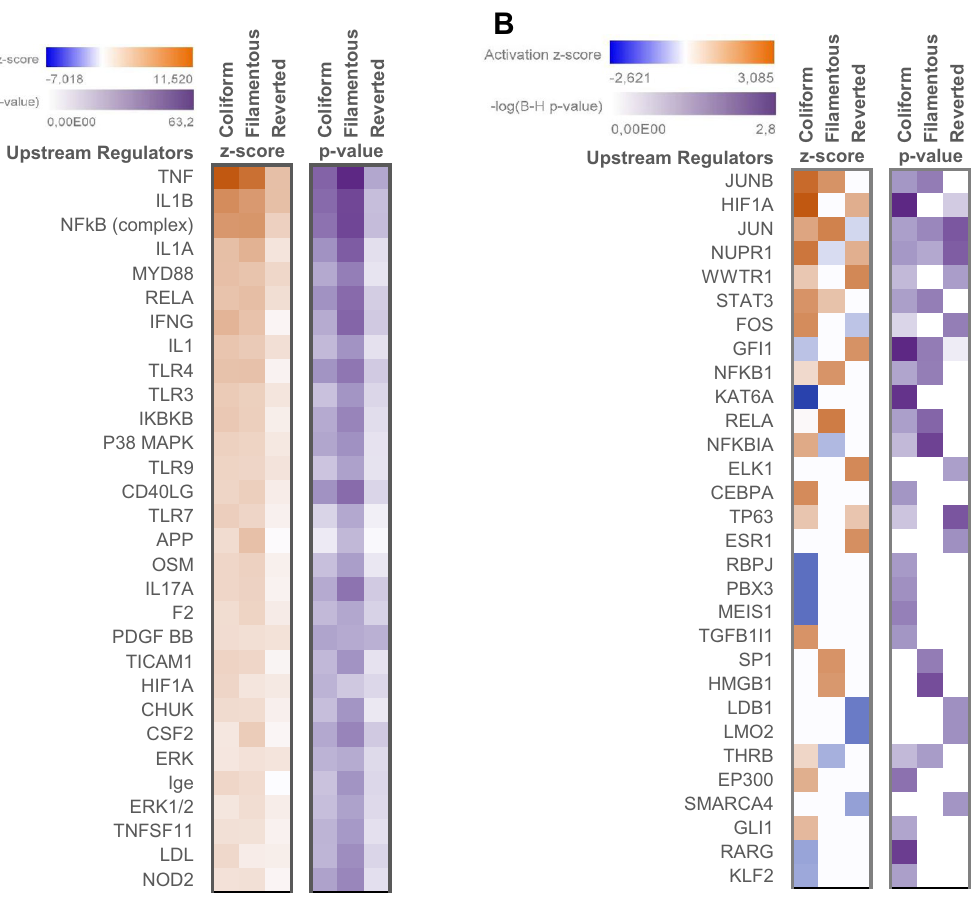
Figure 3. A comparative analysis of ( A ) shared upstream regulators altered in HBEP cells after stimulation with all three morphologies (Coliform, Filamentous, Reverted) compared to unstimulated control cells, ( B ) upstream regulators for gene entities that were uniquely altered in HBEP cells after stimulation with only one of the three morphologies (only Coliform, only Filamentous, only Reverted) compared to unstimulated control cells. The top 30 upstream regulators are shown, and data are presented as activation z-score and − log B-H corrected p